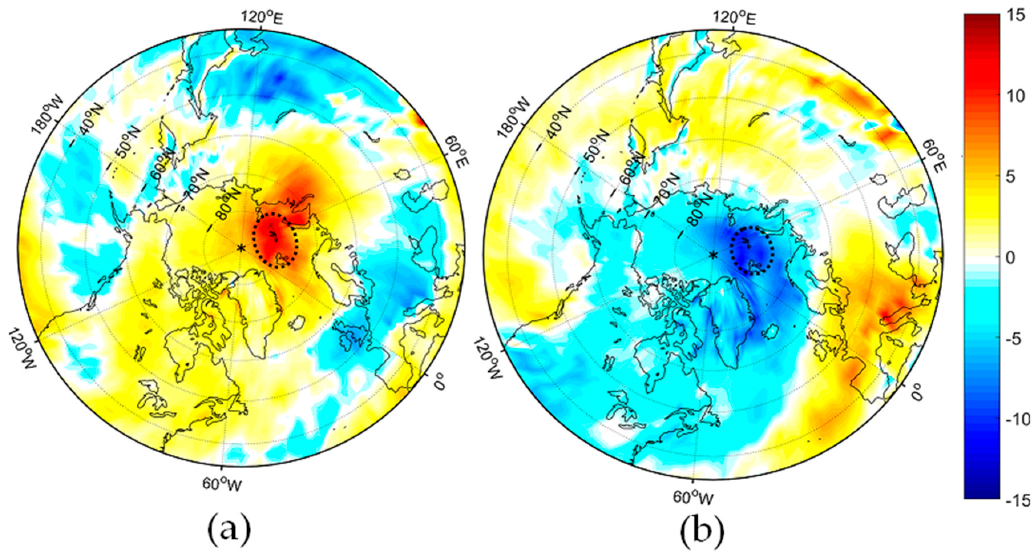
Figure 10. ( a ) Outgoing long-wave radiation (OLR) anomaly in low sea ice index years (2007, 2008, 2012, 2016); ( b ) OLR anomaly in high sea ice index years, unit: W/m 2 . The black part passed the t test at 90% confidence (1988, 1992, 1994, 1996, 1997, 1998, and 2001).